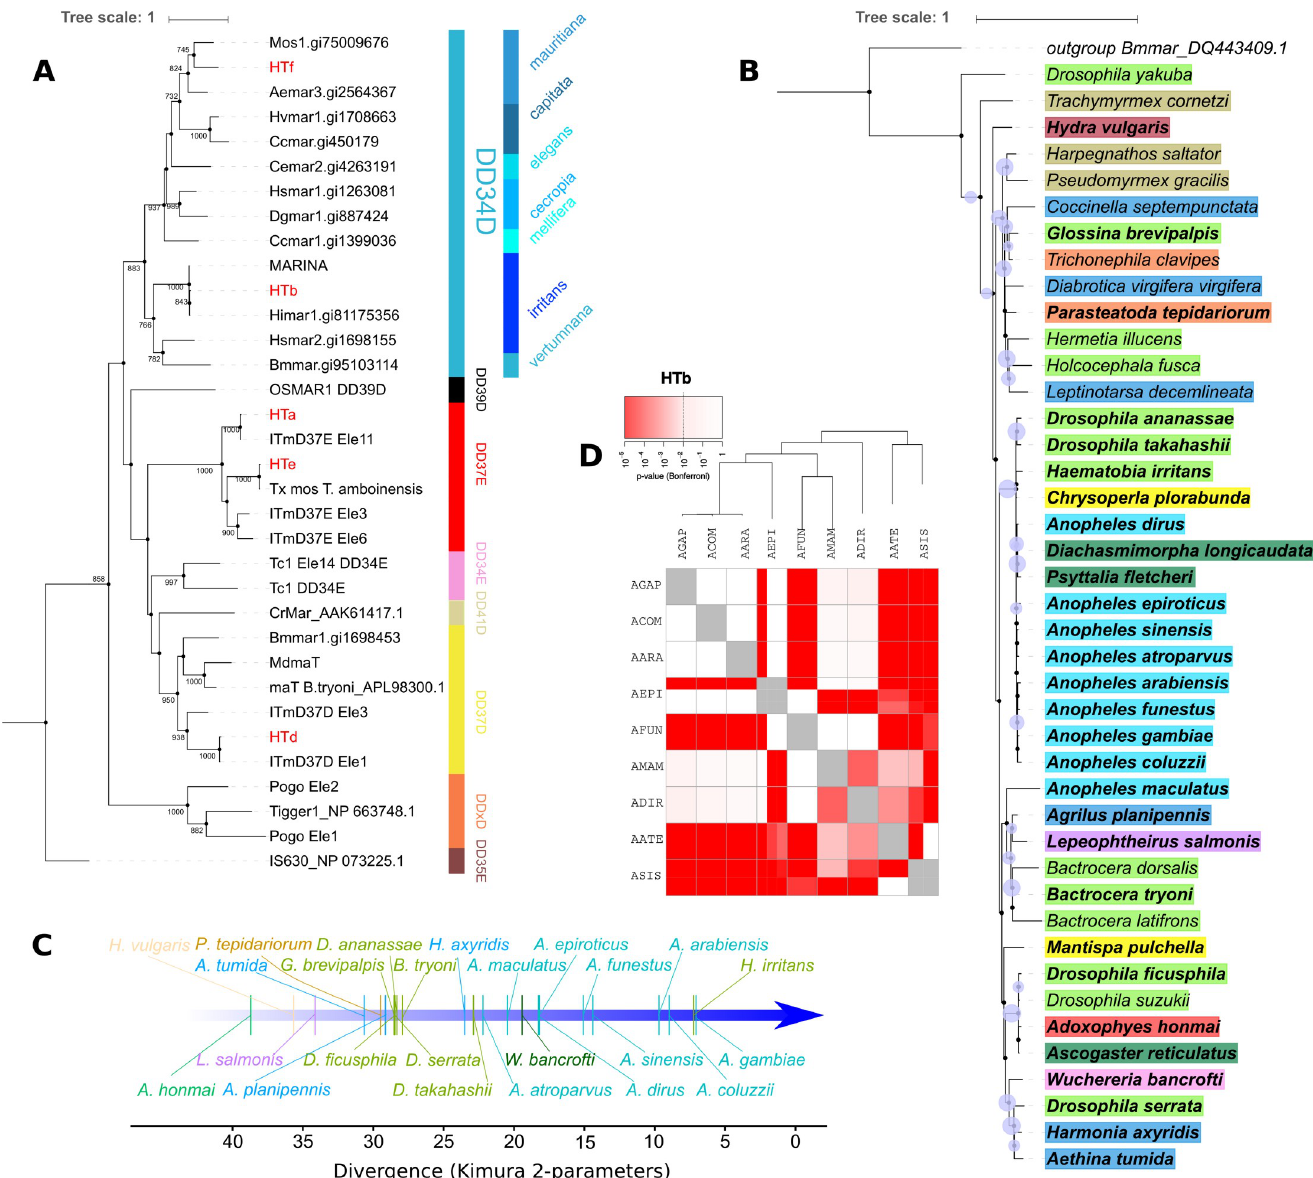
Fig 6. Transposons horizontally transmitted to other species. (A) A phylogenetic tree based on the transposase amino acid sequences of multiple ITm superfamily elements (bootstrap values are showed at nodes), including five Anophelinae TEs (labeled in red) involved in HTT events with other metazoan species and many elements that have already been described. The tree topology indicates that these five TEs belong to different families. HTb represents an element that is widespread in many metazoan genomes, as shown in the nucleotide-based phylogenetic tree of part B. A species name in bold represents elements that share more than 80% of similarity to Anopheles ones. Brachycera is highlighted in light green, cnidarians in dark brown, ants in light brown, spiders in orange, beetle in blue, elements from the Anopheles genus in light blue, parasitoid wasps in dark green, Neuroptera in yellow, Lepidoptera in red, crustaceans in purple, nematodes in light purple. (C) A timeline built up using K2P distances showing the average relative age of elements in the genome of each species. (D) VHICA graphical representation of the HTb element in mosquitoes. The red-colored boxes represent statistically significant HTT signals.